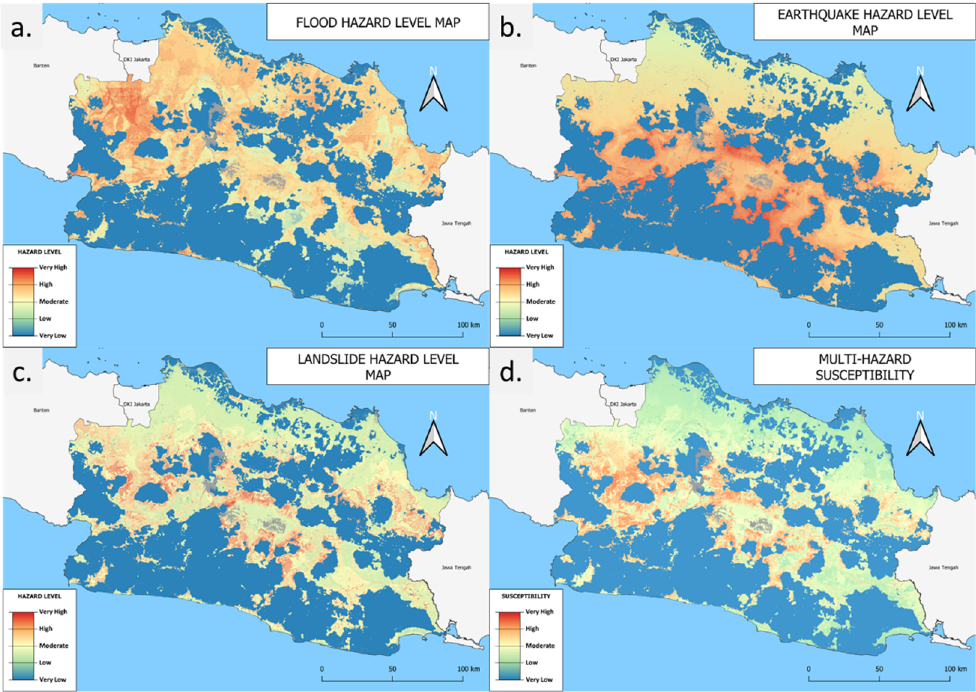
Figure 7. Disaster hazard distribution for: ( a ) floods, ( b ) earthquakes, ( c ) landslides, and ( d ) the total multi-hazard susceptibility index.